Question: In a single sentence, describe what this figure presents.
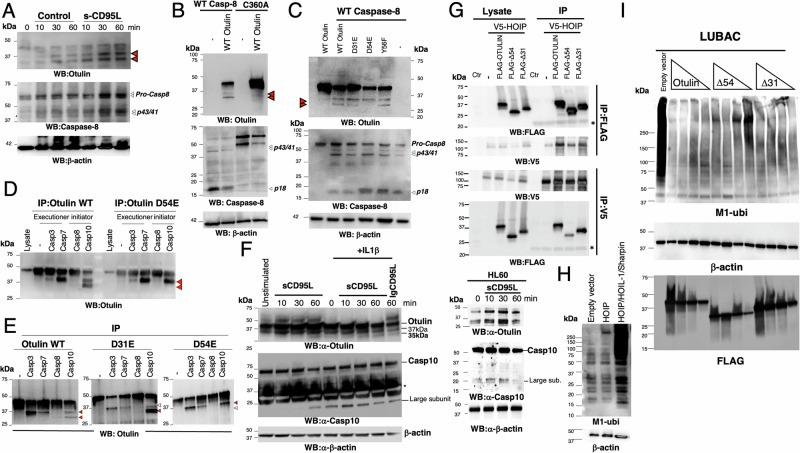
Answer: Caspase-10-mediated cleavage of OTULIN at D54 in neutrophils. A DMSO-differentiated HL60 cells were stimulated with sCD95L (100 ng/mL) for the indicated times. Cell lysates were analyzed by immunoblotting; β-actin served as a loading control. B HEK293T cells co-transfected with wild-type (WT) or inactive (C360A) caspase-8 with WT OTULIN were analyzed 24 h post-transfection. Activation of WT caspase-8 induced OTULIN cleavage, generating two fragments ( ~ 37 and ~ 35 kDa) (red arrows), whereas C360A did not. Caspase-8 activation is monitored by the detection of processed p43/p41 and p18 fragments. These cleavages only occured for WT. C HEK293T cells were co-transfected with WT caspase-8 and indicated OTULIN mutants. The ~ 35 kDa cleavage product observed with WT OTULIN was abolished with the D54E mutant. D Flag-tagged WT OTULIN or D54E mutant was immunoprecipitated with anti-Flag-coated beads and incubated with indicated recombinant caspases for 90 min, followed by SDS–PAGE and immunoblotting. The ~ 35 kDa cleavage product (red arrows) was detected for WT OTULIN incubated with active caspase-10 but not for D54E. E Flag-tagged WT, D54E, or D31E OTULIN constructs were processed as in (D). The two cleavage products (red arrows) observed for WT OTULIN incubated with caspase-10 were reduced or absent in mutants. F Left: Primary human neutrophils, pre-treated or not with IL-1β, were stimulated with sCD95L or IgCD95L (100 ng/mL). Right: HL60 cells were treated with sCD95L. Lysates were analyzed by immunoblotting; β-actin served as a loading control. G HEK293T cells co-transfected with V5-HOIP and Flag-OTULIN constructs were subjected to anti-V5 or anti-FLAG immunoprecipitation followed by immunoblotting to assess interactions. Input and immunoprecipitates are shown. H HOIP alone or the whole LUBAC complex (HOIP/HOIL-1/Sharpin) was expressed in HEK293T cells, and linear ubiquitination (M1-ubi) was analyzed by immunoblotting 48 h post-transfection. I HEK293T cells were co-tran